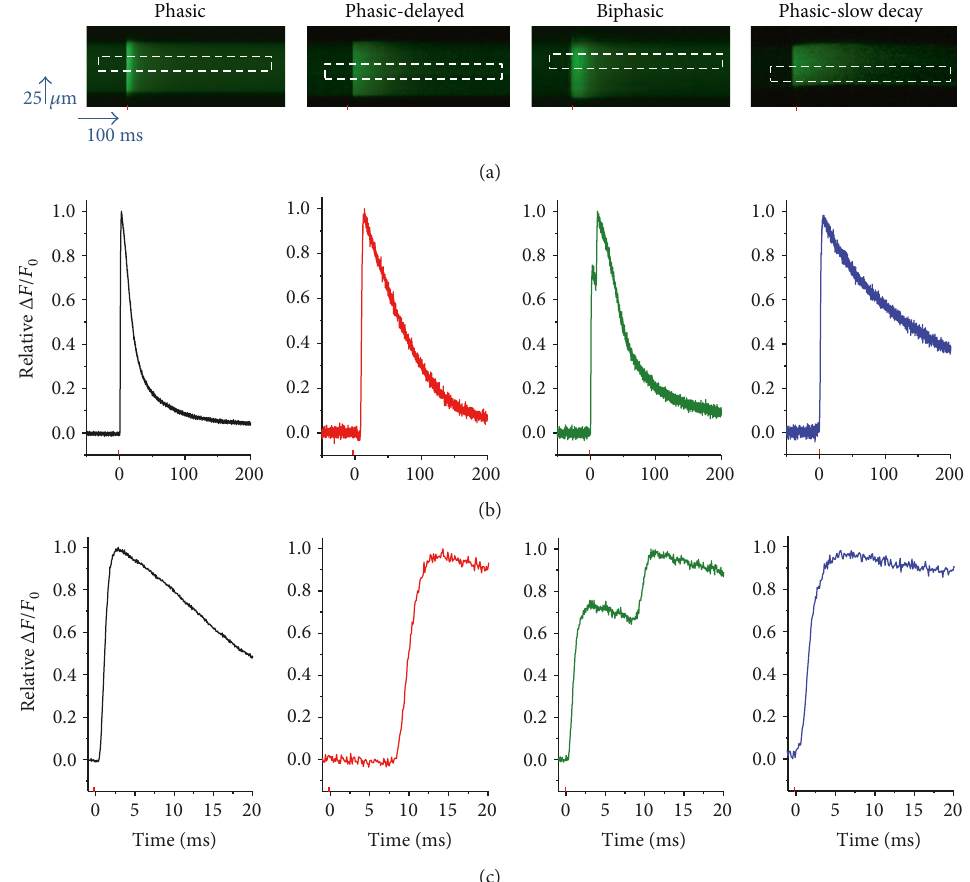
Figure 1: Muscle fi bers cultured for 5 days exhibit multiple patterns of action potential (AP)-induced Ca 2+ transients: control conditions. (a) Representative confocal line-scan images of AP-induced Ca 2+ transients in 5-day-old cultured muscle fi bers maintained in control medium. Note that four di ff erent patterns were identi fi ed: phasic, phasic-delayed, biphasic, and phasic-slow-decay. The red mark indicates the time when fi eld electrical stimulus was applied, and the dashed rectangle illustrates the region of interest used to measure the time course of the Ca 2+ transient. (b) Time course of the AP-induced Ca 2+ transients shown in (a). (c) Zoomed-in versions of AP-induced Ca 2+ transients shown in